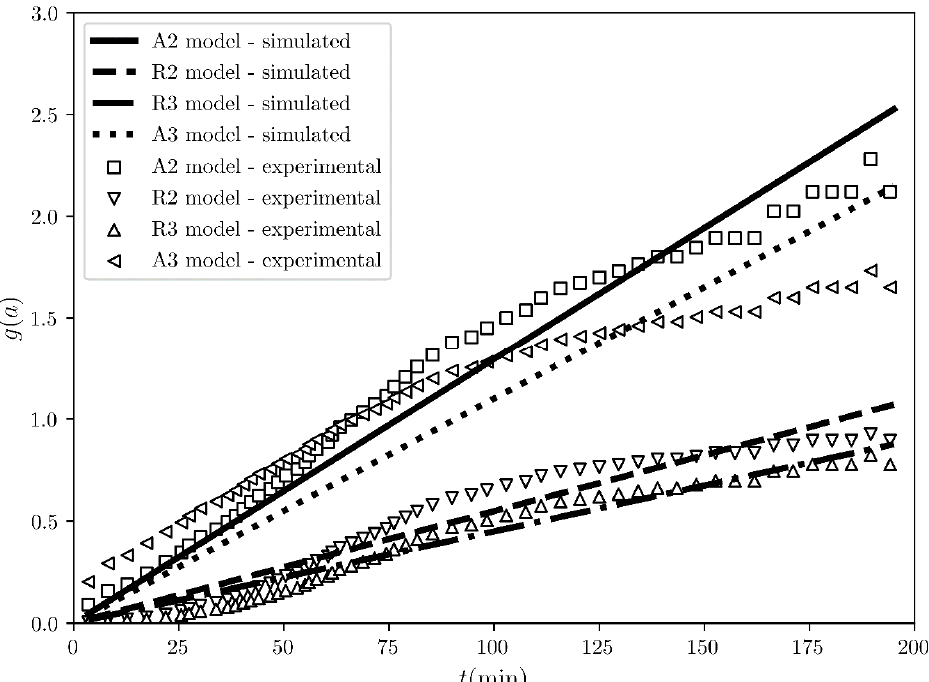
Figure 1. The integral reaction rate time evolution regarding the desolvation of the sulfameter solvate at 47.19 °C. The scatter plots represent the rates evaluated from the experimental conversion fraction measured by A. Khawam and D. Flanagan [4], while the solid and dashed black lines represent the straight line fits for the “best” four models ranked by COMF, i.e., A2, R2, R3 and A3 models. Table 2. The determination coefficients calculated at every step of the COMF method in the case of the desolvation of sulfameter solvates at 47.19 °C.